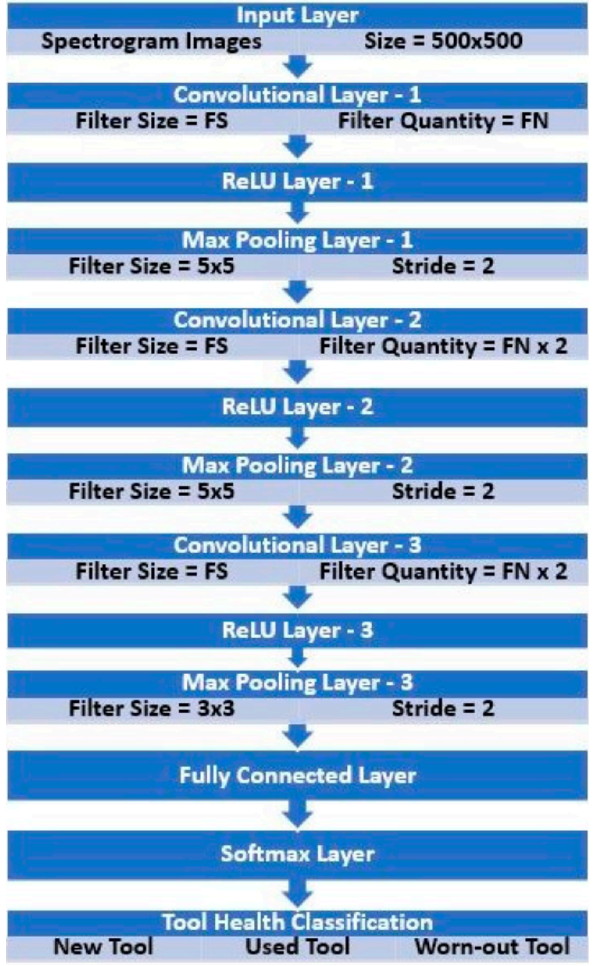
Figure 28. CNN architecture with layers sequence where FS = convolutional filter size, FN = number of convolutional